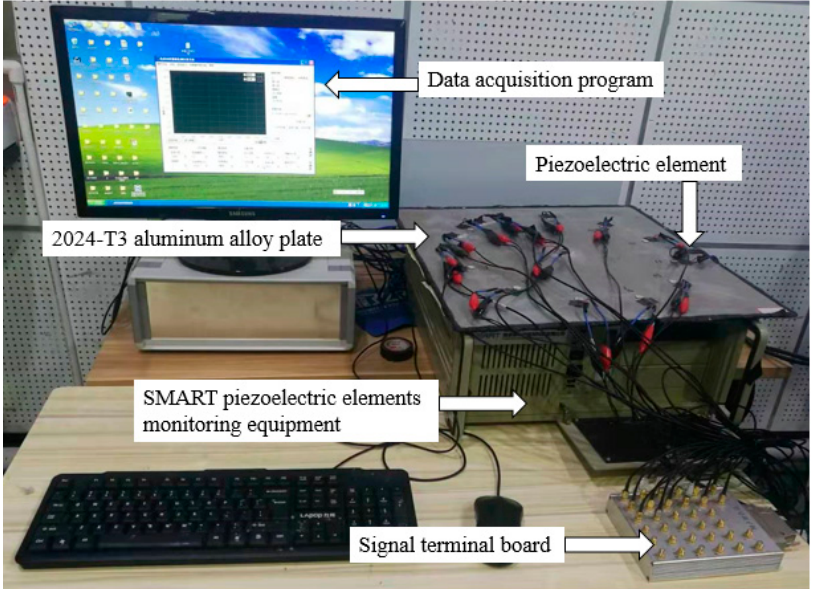
Figure 4. Establishment of structural health monitoring system for piezoelectric elements.